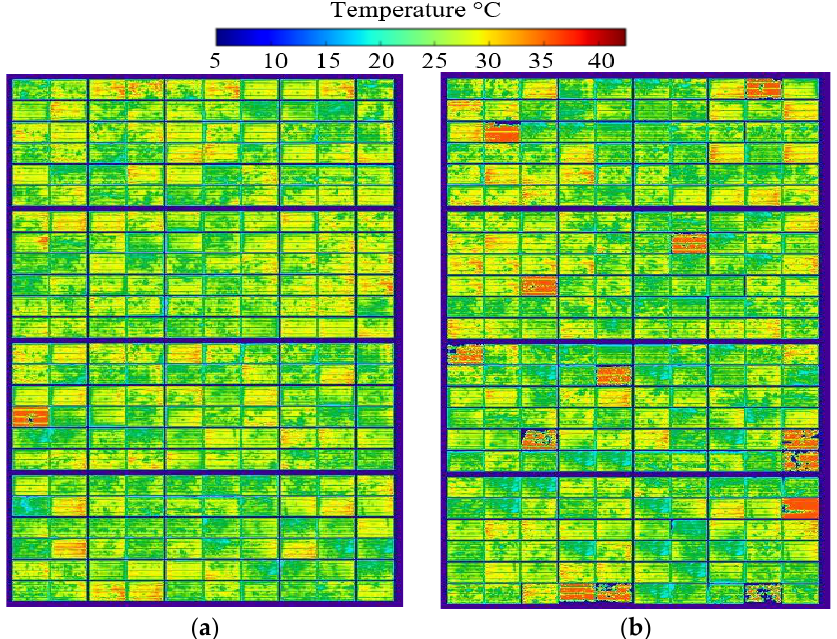
Figure 10. Thermal images of the tested PV strings after three years of field operation, taken under 830 W/m 2 solar irradiance and a PV surface temperature of 23.3 °C: ( a ) PV string 1, ( b ) PV string 2.